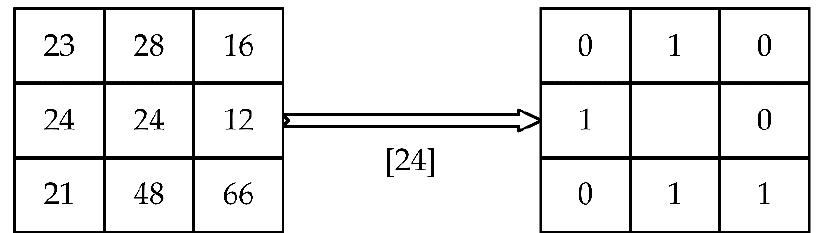
Figure 5. LBP operator coding process diagram.